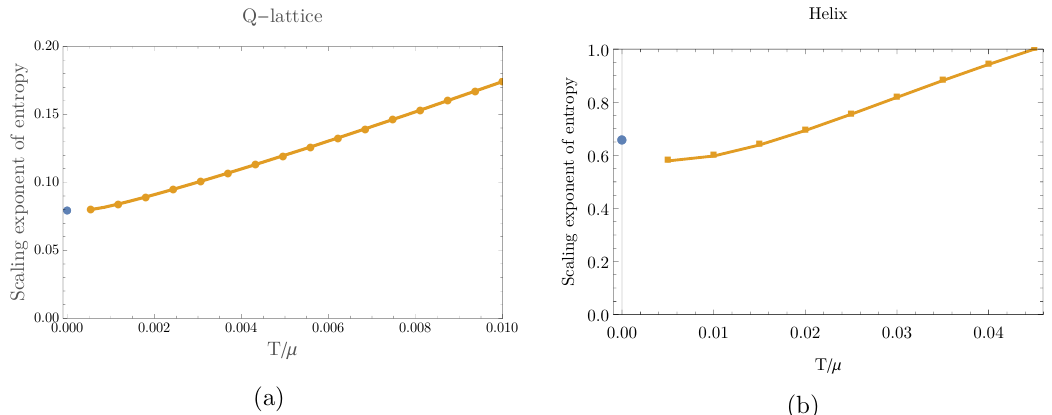
Figure 1. Entropy scaling in the two holographic models under consideration. The fact that the scaling exponent is larger than zero temperature means that our models do not (cid:13)ow to the metallic AdS 2 (cid:2) R d (cid:0) 2 (cid:12)xed point in the IR and that the translation symmetry breaking is relevant. Blue dots are the analytical values obtained from near-horizon analysis of zero-temperature solutions [14, 15]. (cid:12) second gauge (cid:12)eld B = (cid:21) ! ( p ) , where ! ( p ) (cid:12) 2 r =0